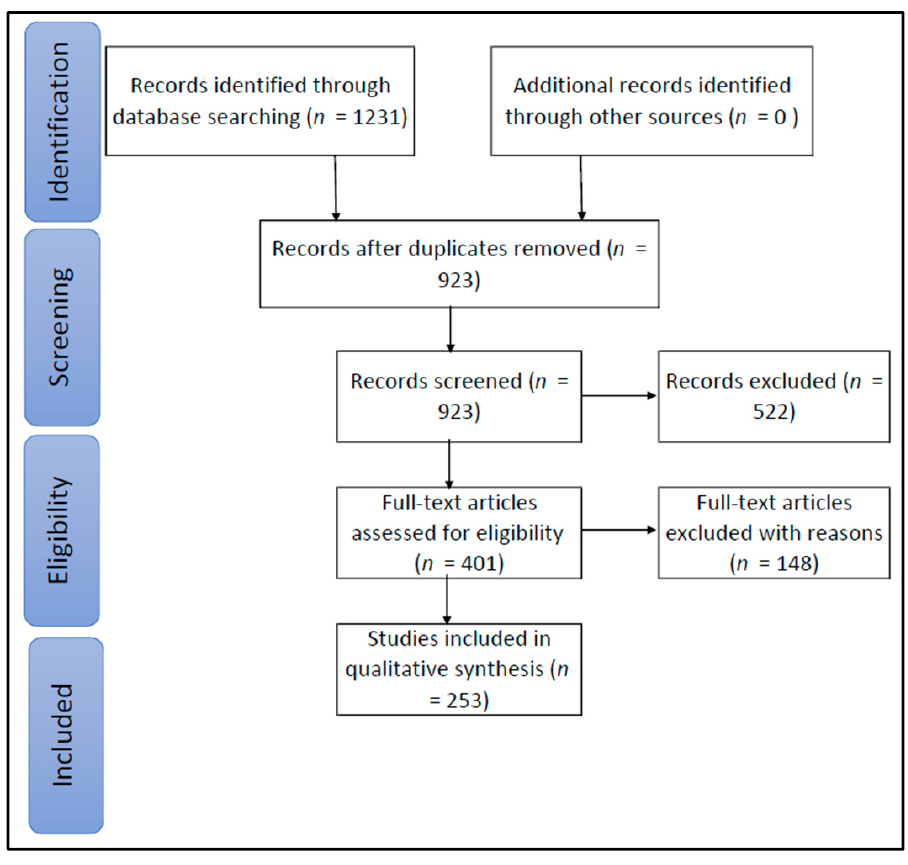
Figure 1. Chart of the selection strategy.